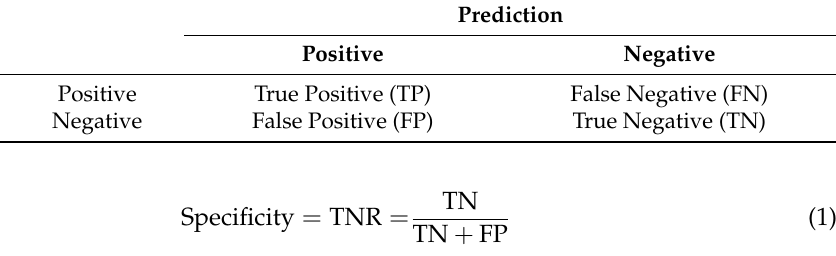
Table 5. Confusion Matrix.